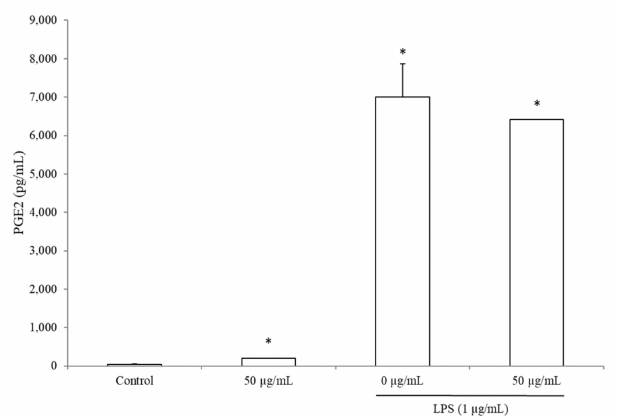
Figure 4. BRE increased PGE2 production without LPS. Cells were incubated with BRE as indicated and stimulated with LPS (1 µ g / mL) for 24 h. Data were shown as means ± SD; * p < 0.05 compared with Control (paired t -test).